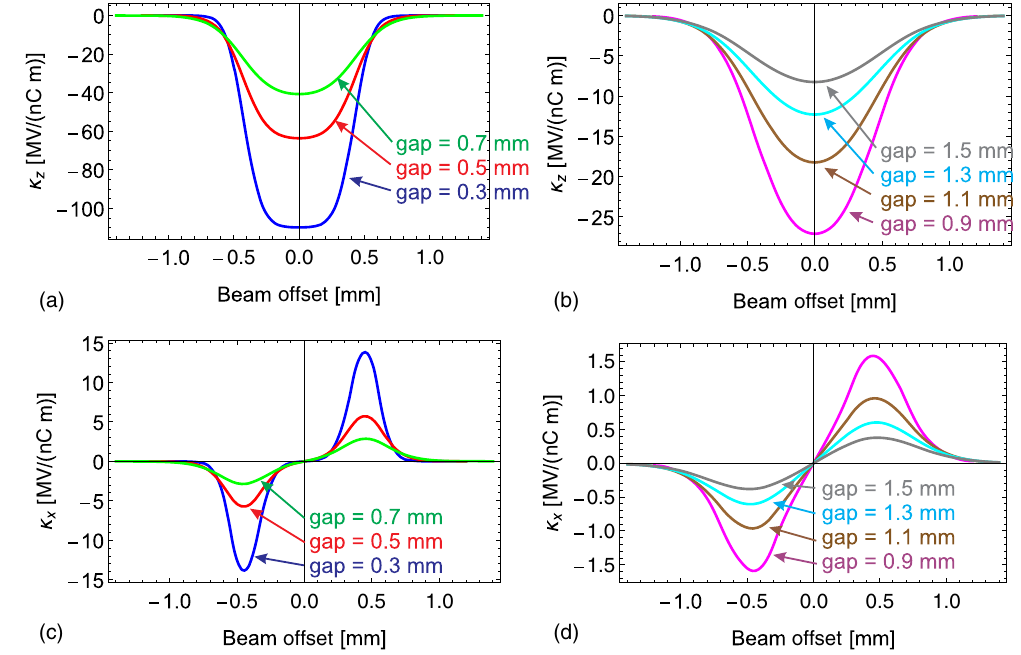
FIG. 10. Loss factor (a),(b) and kick factor (c),(d) as a function of the horizontal beam-structure displacement, for different gaps. The ¼ 50 μ m bunch in a 10 cm long fields are generated by a σ z